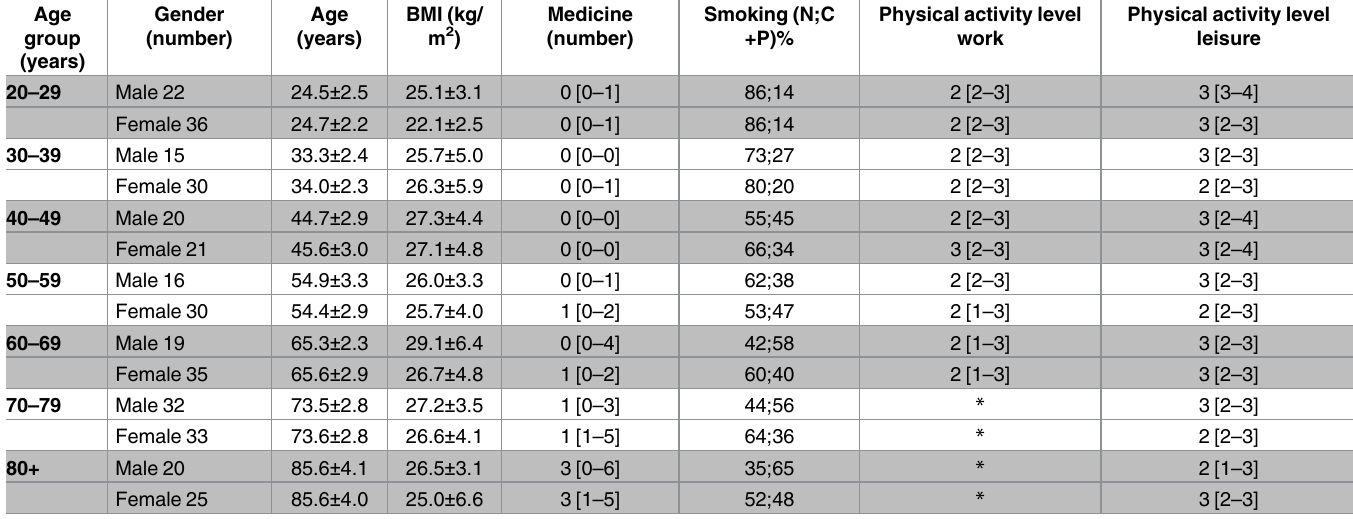
Table 1. Anthropometric data.